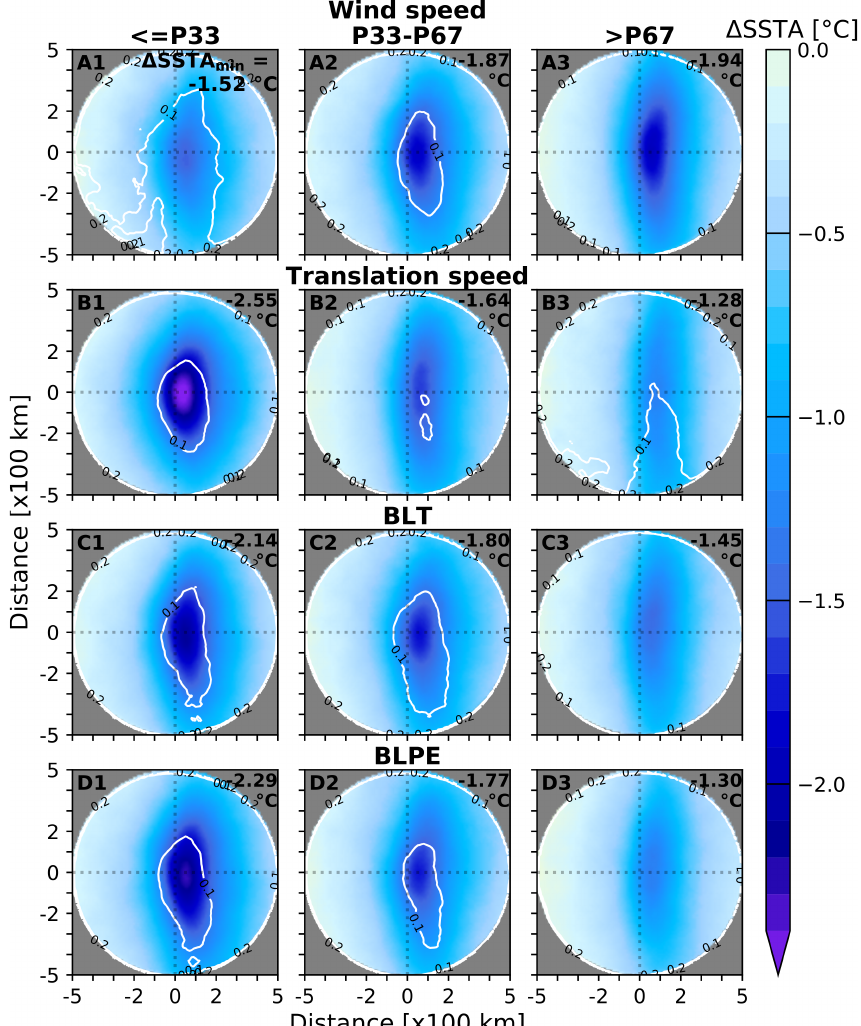
Figure 7. Mean composites of ∆ SSTA based on the merged SST dataset for the following parameters: ( A1 – A3 ) 10-min maximum sustained wind, ( B1 – B3 ) hurricanes translation speed, ( C1 – C3 ) barrier layer thickness (BLT), ( D1 – D3 ) barrier layer potential energy (BLPE). First column for values below percentile 33, second column for values within the range P33 and P67, third column for values over percentile 67. Percentiles are indicated in Figure 5 and in Table 2. The margin of error of ∆ SSTA is depicted by white